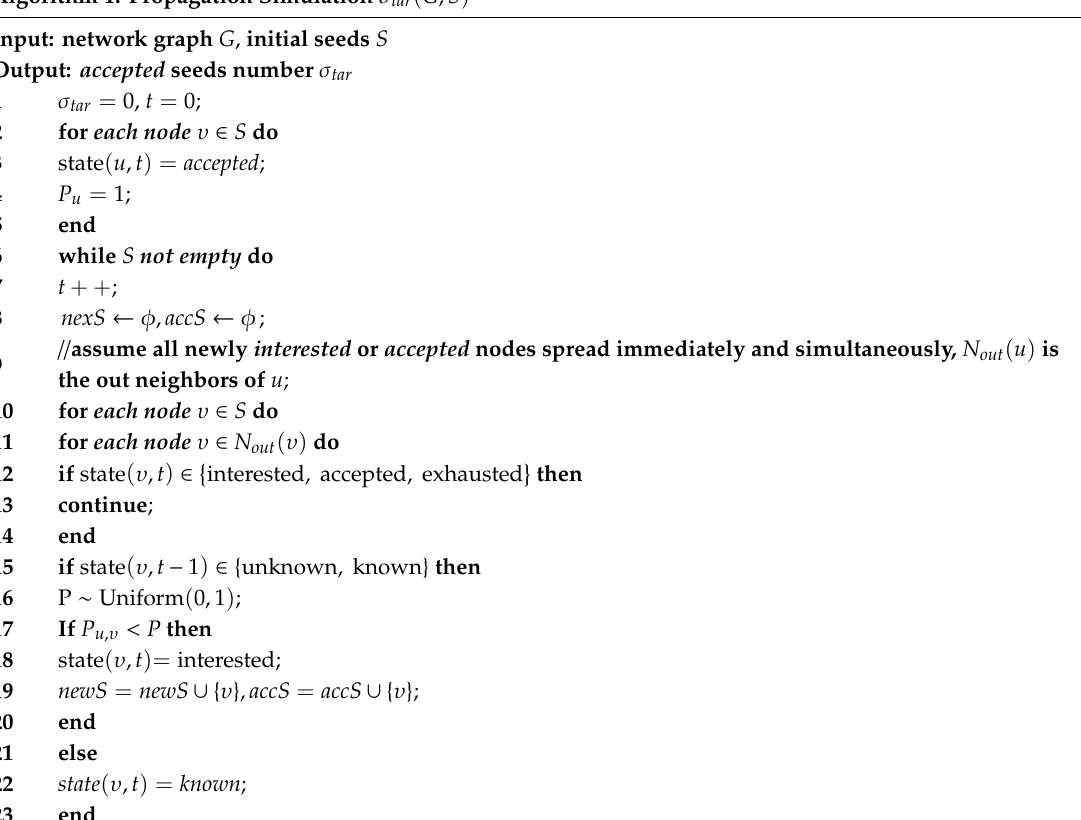
Algorithm 1: Propagation Simulation σ tar ( G , S